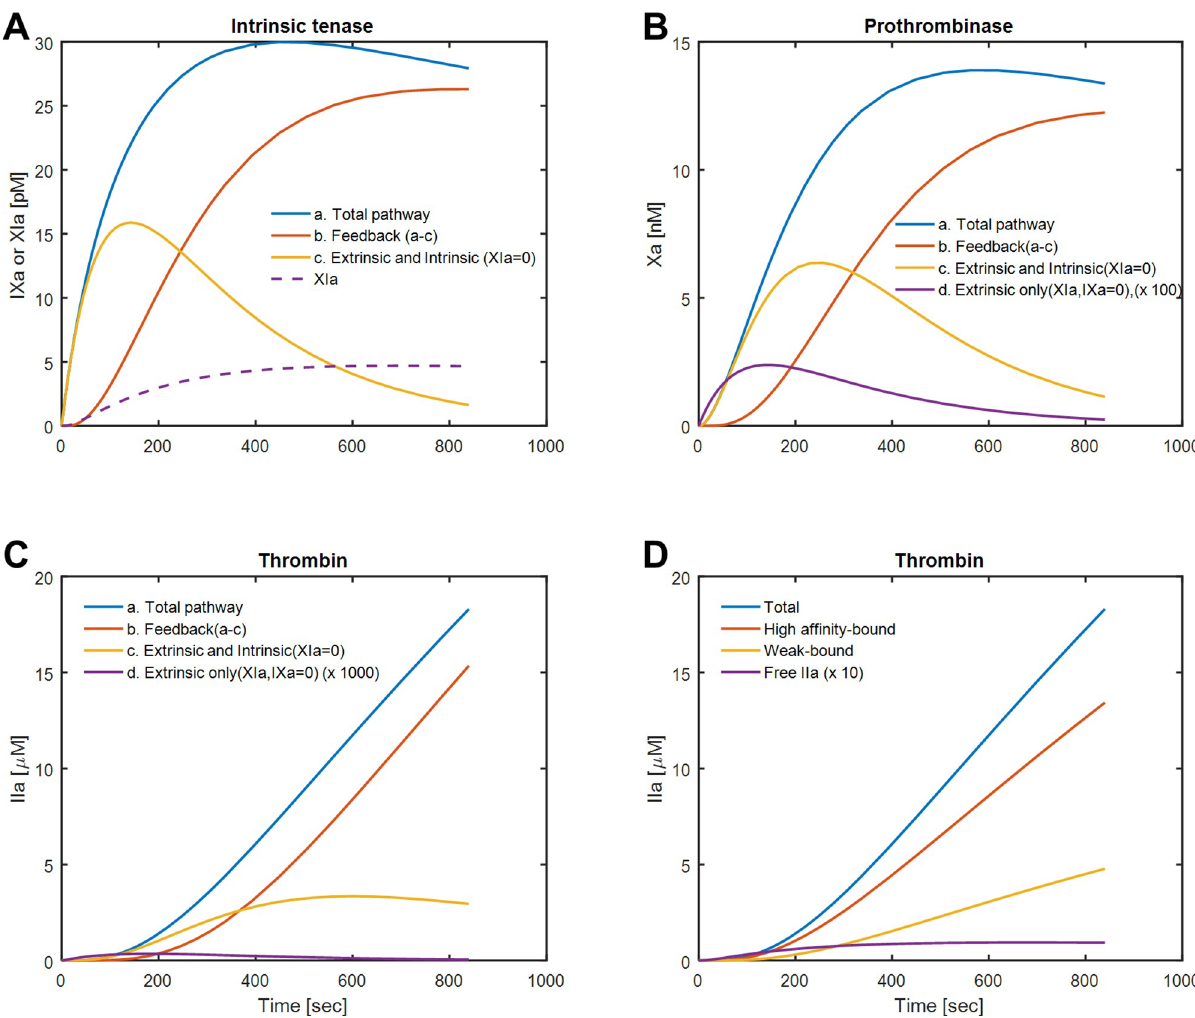
Fig 3. Concentration of the procoagulants predicted by the ODEs model. The concentration of FIXa (ie the intrinsic tenase, FIXa/FVIIIa) generated by all pathways (a,blue), in the absence of feedback with FXIa = 0 (c, orange) and by the FXIa-feedback pathway (b, red) calculated via a-c. (A). FXIa is shown as dashed-line. The concentration of FXa (ie. Prothrombinase, FXa/FVa) generated by various pathways (B) demonstrating that only a minor fraction of FXa is derived from TF/VIIa in the simulation. The concentration of thombin generated via various pathways (C). The majority of intrathrombin thrombin is bound to the γ ’-site in fibrin with < 100 nM as free thrombin (D).